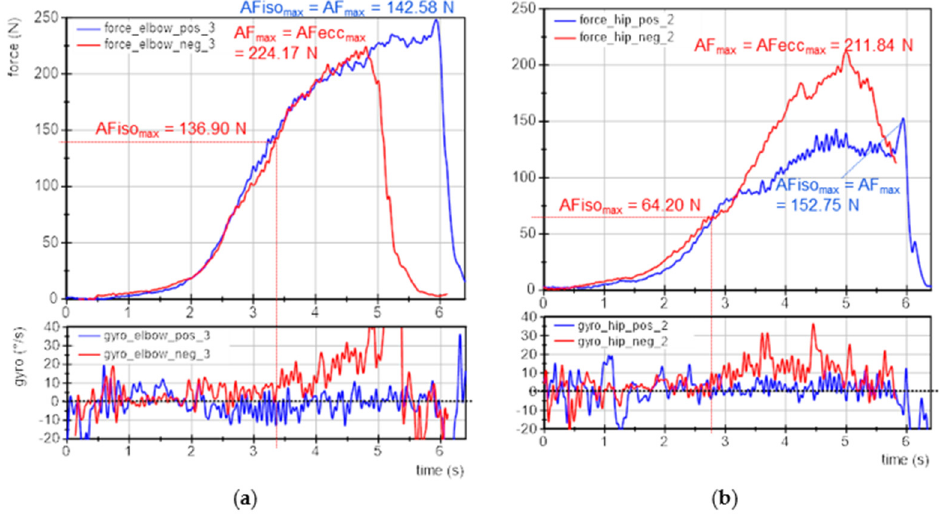
Figure 7. Case example: exemplary signals of objectified MMT. Displayed are the force (N) and gyrometer signals (°/s) during MMTs of ( a ) elbow and ( b ) hip flexors of the same participant (age: 27 years, height: 174 cm, body mass: 69 kg) during positive (blue; pos) and negative (red; neg) imagery. Marked are the parameters AF max , AFecc max and AFiso max .